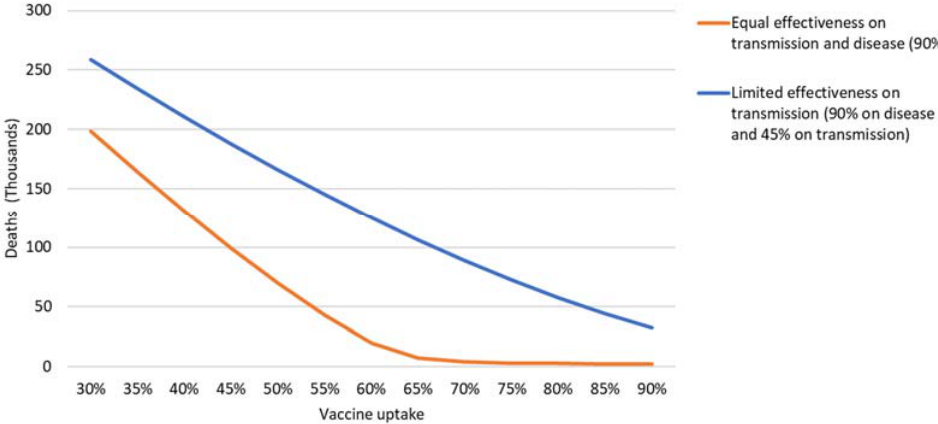
Figure 10. The total number of deaths in the first year after vaccination for the two scenarios for varying vaccine uptakes.